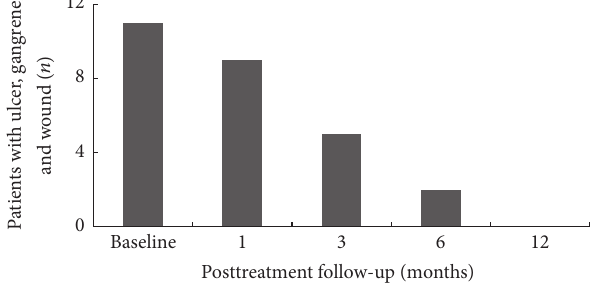
Figure 7: Summary of ulcer, gangrene, and wound healing.